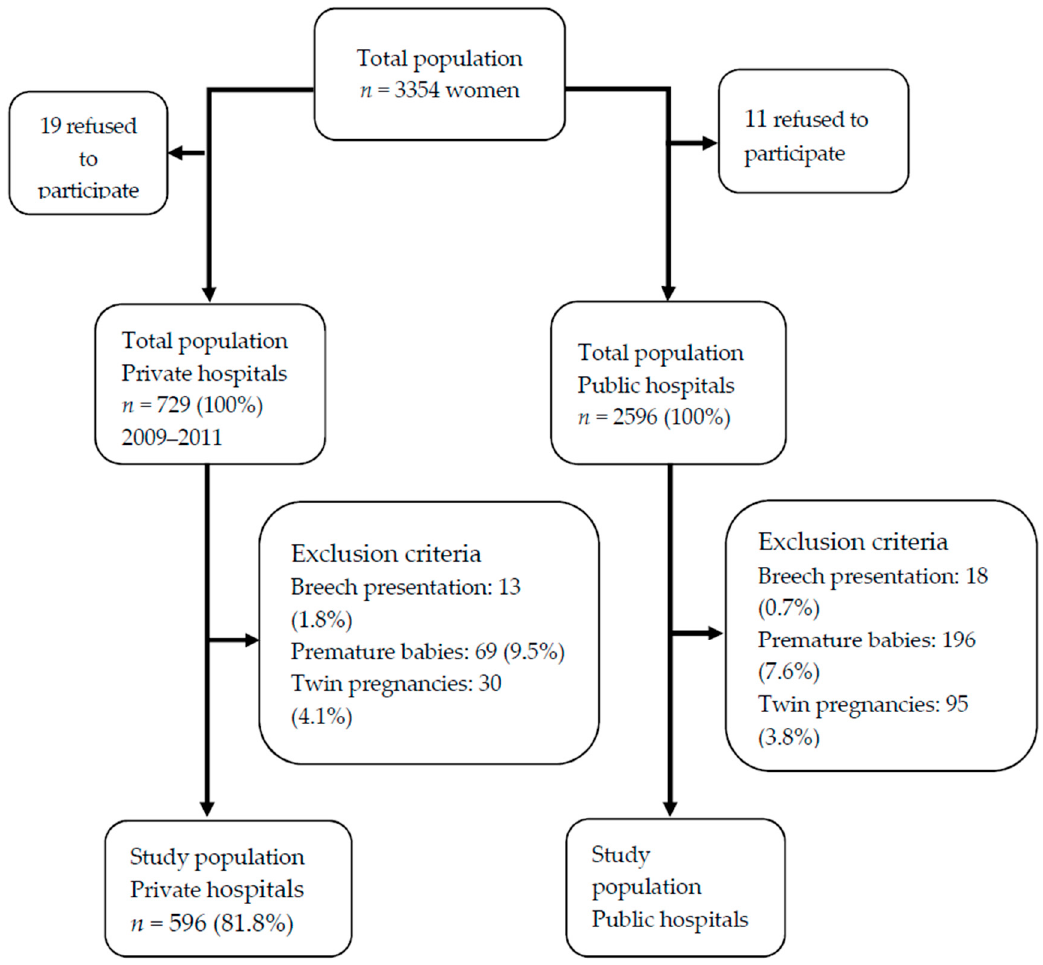
Figure 1. Diagram showing the process followed for the selection of the study subjects.